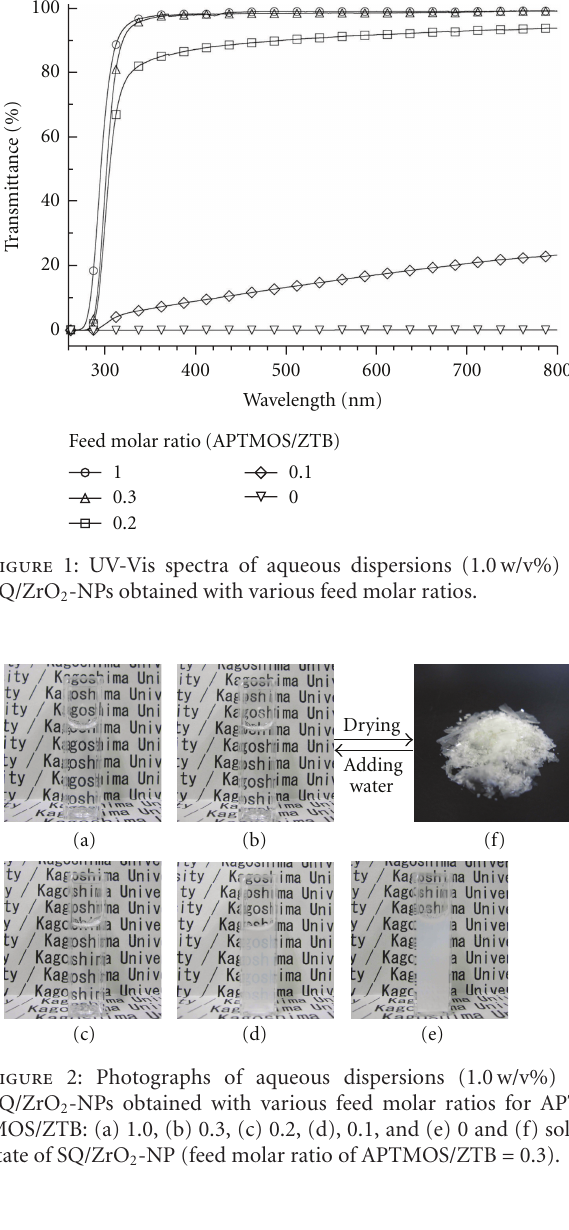
SiO 1 . 5 (CH 2 ) 3 NH 3 + Cl − components, which play an